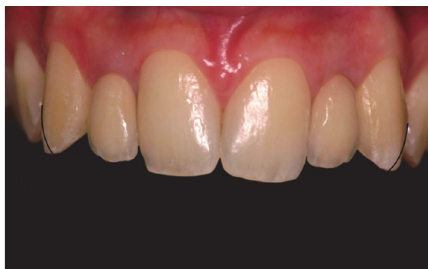
Figure 3: Frontal view of selective enamel recontouring of canine maxillary using a guide in order to reduce the buccal inclination, especially in the incisal third, and obtain an incisal angle more